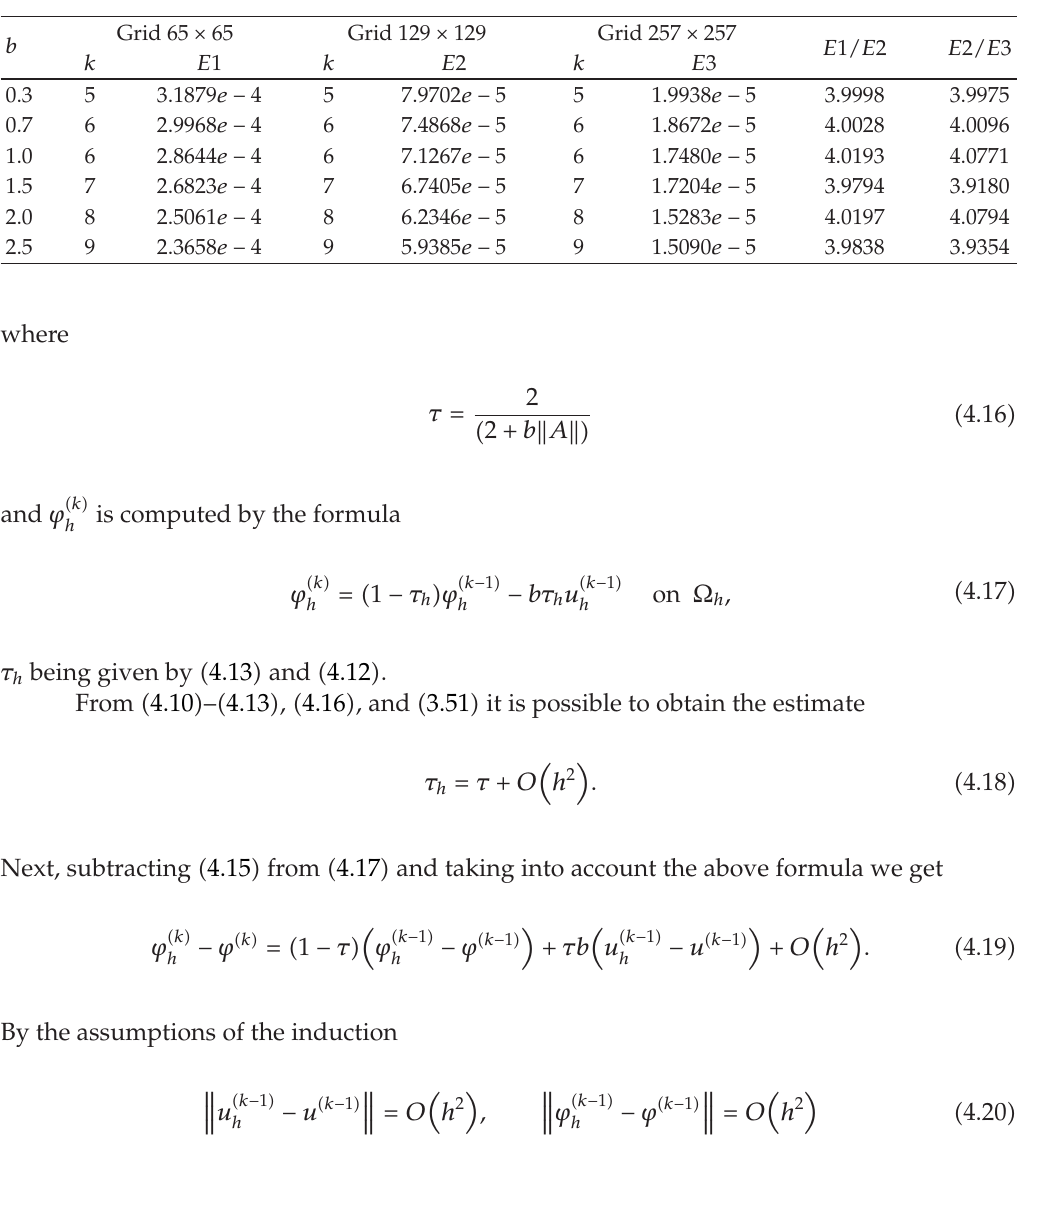
Table 3: Convergence of the method in Example 4.3 for a (cid:10)